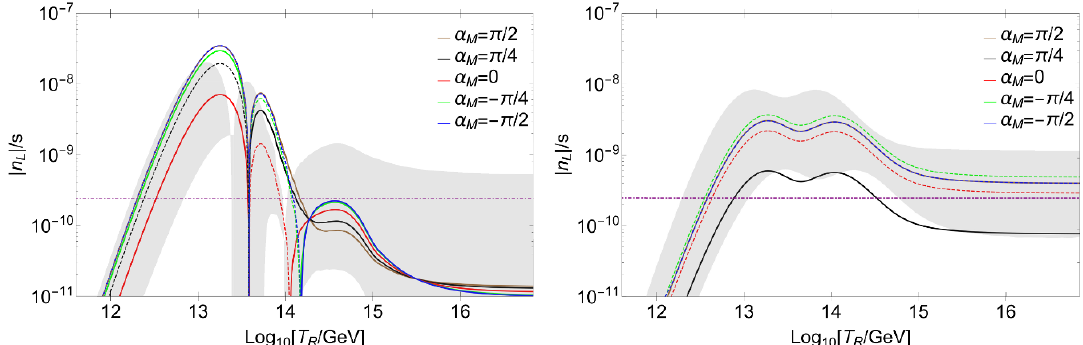
Figure 3 . The dependence of lepton asymmetry on the reheating temperature when the in(cid:13)ation main decay channel is Higgs boson with several (cid:11) M with (cid:14) = (cid:0) (cid:25)= 2. The normal and inverted mass hierarchies for neutrinos are shown in left and right panels, respectively. m (cid:30) =T R = 100, B = 1 and m (cid:23) lightest = 0 eV are (cid:12)xed. The shaded regions denote the uncertainty for (cid:14) = (cid:0) (cid:25)= 2 ; (cid:11) M = 0 for comparison. The solid and dashed lines denote the sign of the asymmetry is minus and plus, respectively (the required asymmetry is minus). The lines are obtained by taking C = C 0 =